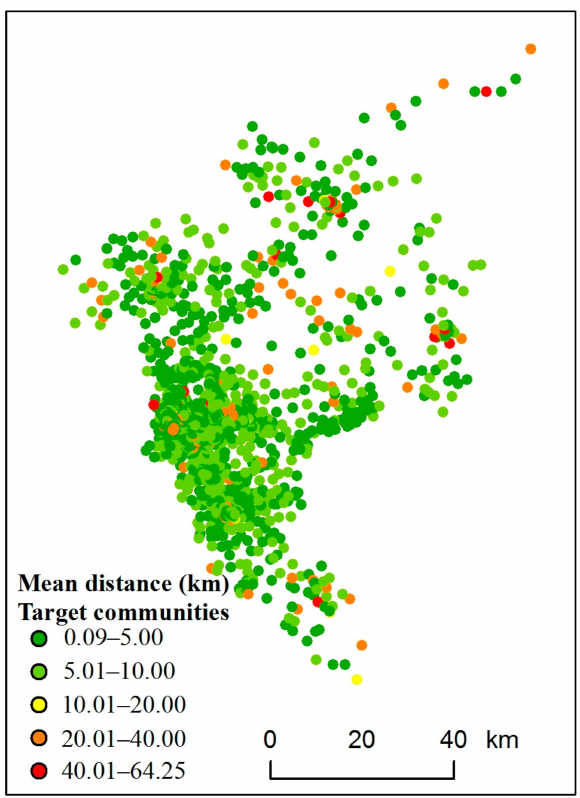
Figure 3. Mean distance at the target